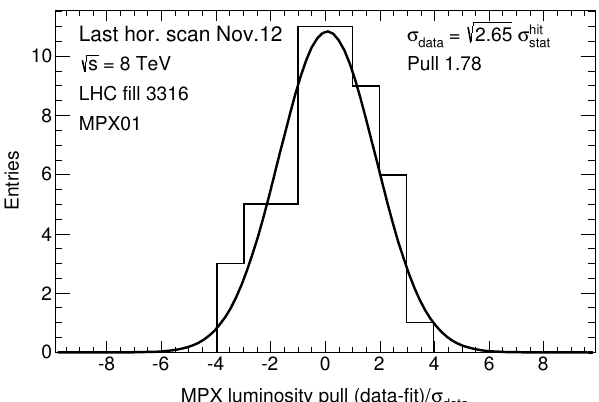
√ R · σ hit and the ratio (the stat